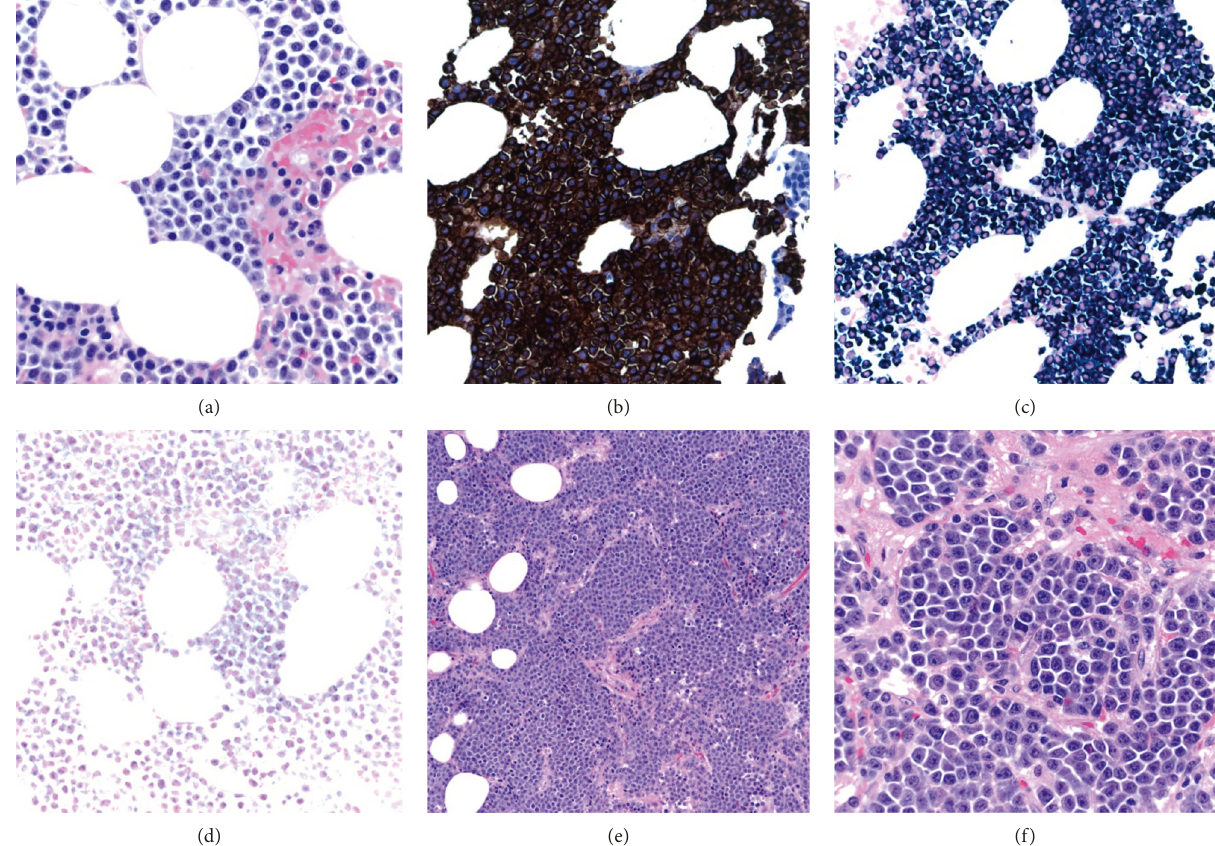
Figure 2: (a) Bone marrow infiltrated by plasma cells. (b) Bone marrow immunohistochemistry revealing CD138 positive cells. (c) Bone marrow immunohistochemistry positive for kappa light chains. (d) Bone marrow immunohistochemistry negative for lambda light chains. Mesenteric invasion (e) by myeloma cells (10x) and (f) by plasma cells